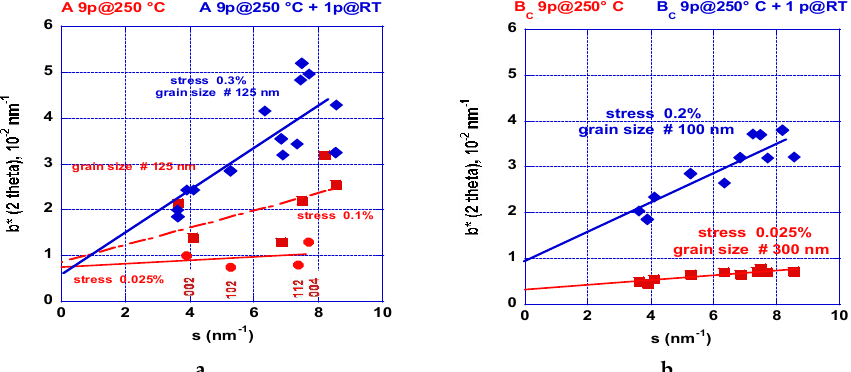
Figure 16. Williamson-Hall [44] plots allow for the determination of the crystallite size and the level of stresses leading modulation of the linewidth of XDR patterns versus the Bragg angle (scattering vector s) for ECAP-treated AZ31 billets at 250 ◦ C: ( a )—mode A - 9 passes, red: (dots and squares: see text), 9 passes + 1 pass at RT (blue), ( b )—mode B C - 9 passes (red), 9 passes + 1 pass at RT (blue). The temperature of 250 °C appears quite critical because being close to the recrystallization temperature and the grains exhibit fine and homogeneous sizes, which is seen in Figures 12 and 13.